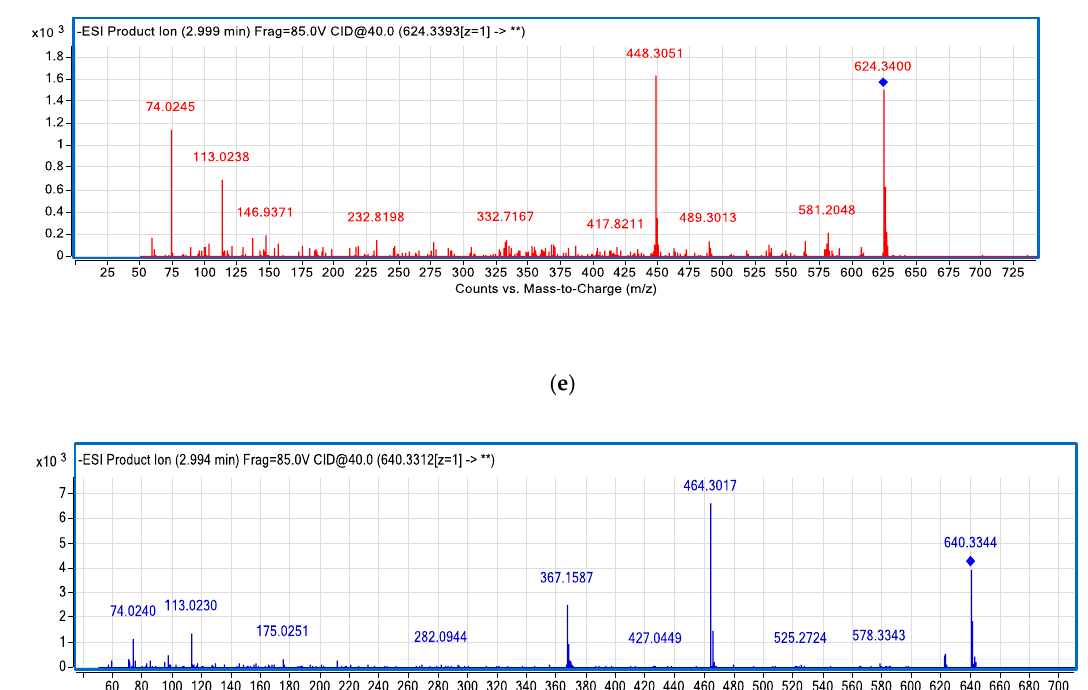
Figure 5. Tentatively proposed structure of glucuronide-GLCA ( a ), glucuronide-GCDCA ( b ), and glucuronide-GCA ( c ). MS/MS spectra of glucuronide-GLCA ( m / z 608.34) ( d ), glucuronide-GCDCA ( m / z 624.34) ( e ), and glucuronide-GCA ( m / z 640.33) ( f ). The MS/MS spectra showing product ions 432.31, 448.31, 464.30 are corresponding to GLCA, GCDCA, and GCA moiety after the loss of the glucuronide group. The fragment 74.02 is corresponding to the conjugate base of glycine.